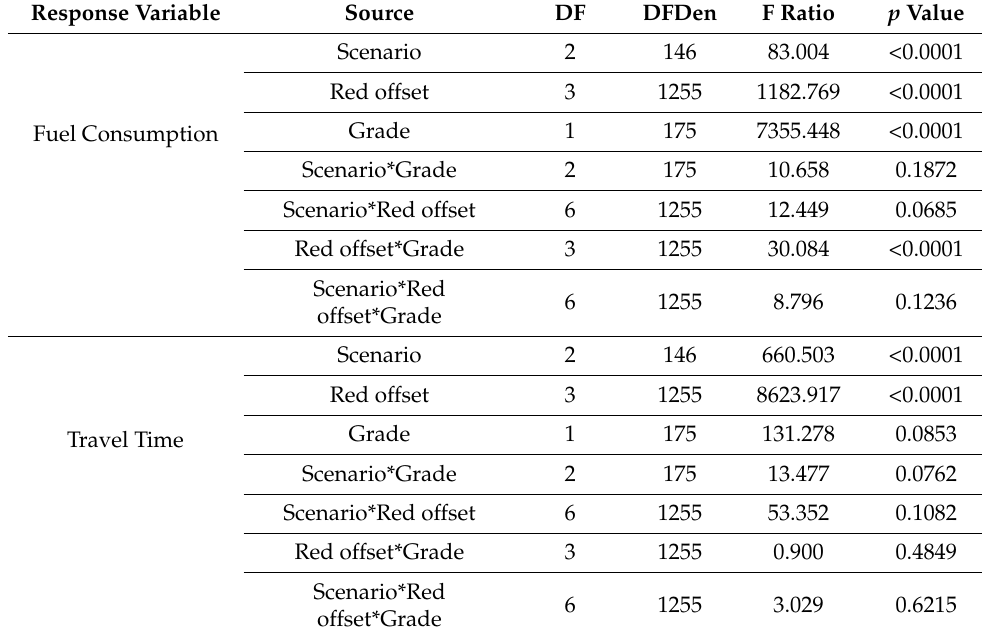
Table 1. Results of fixed effect